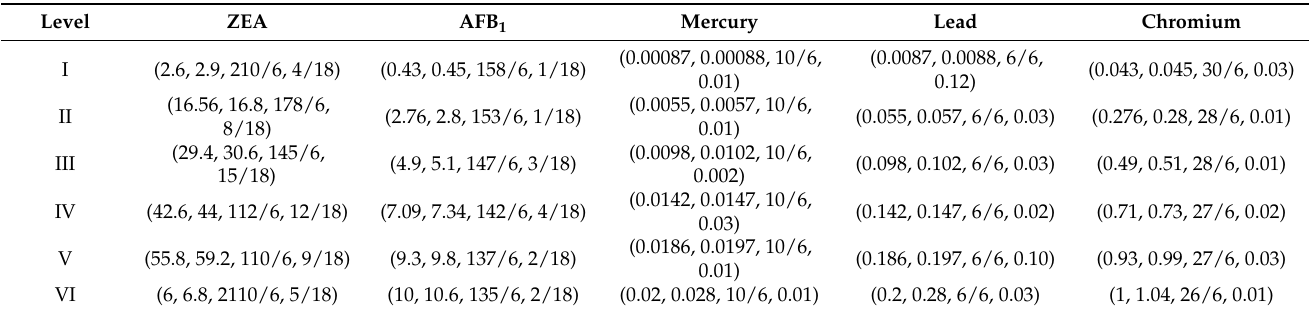
Table 7. Multidimensional trapezoidal cloud model parameters.